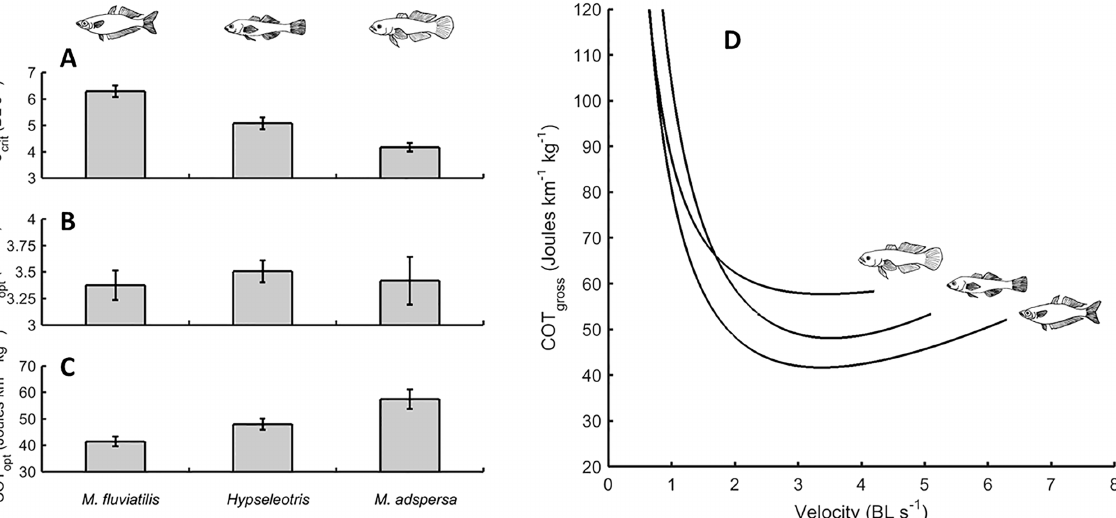
Fig 3. Endurance swimming capacity of three fishes with different lifestyles. Melanotaenia fluviatilis , Hypseleotris sp. and Mogurnda adspersa have, respectively, a fast, intermediate and slow lifestyle (Table 1). A. Critical swim velocities (U crit s). B. Mean optimal swimming speed ( U opt ) in body lengths per second. (C) Mean gross cost of transport at U opt . D. Gross cost of transport functions. Lines are modelled relationships between velocity and COT gross using fixed effects estimates of parameters in Eq 9 (estimates in Table 2). Relationships between COT gross and velocity are presented for each species up to their respective mean U crit values. All error bars are a single standard error. Sample sizes for M . fluviatilis , Hypseleotris and M . adspersa were, respectively: N = 6, 7 and 6.